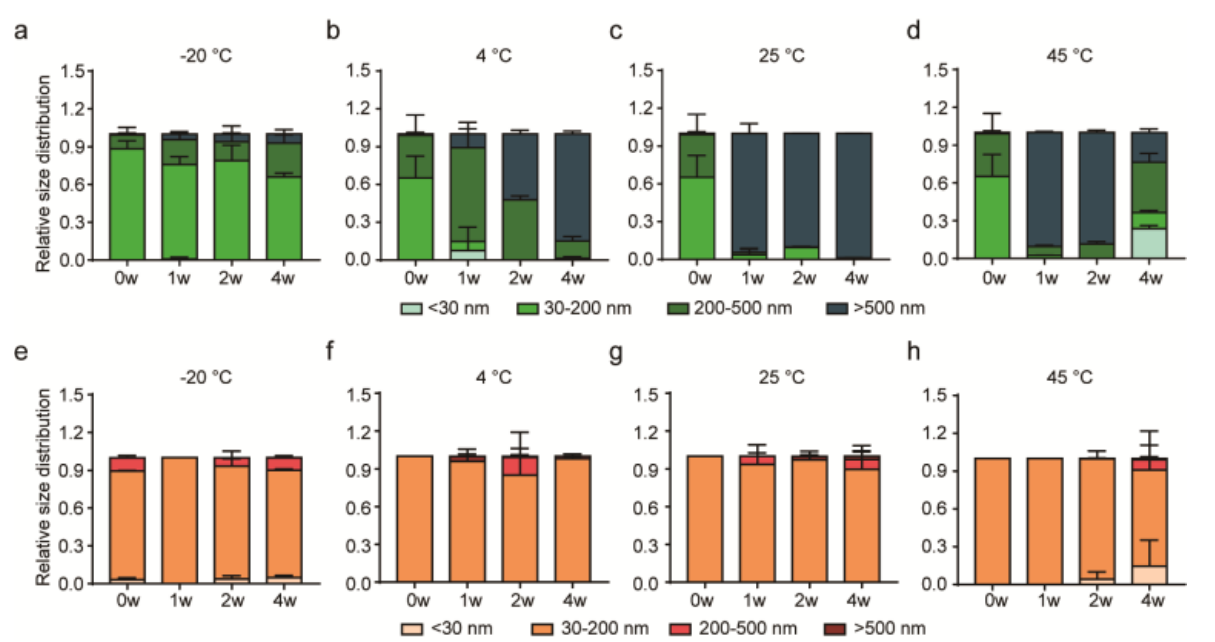
Figure 2. Size distribution changes over time in the various formulations stored at different temper- atures. ( a – d ) Size distributions over time for LEVs stored at − 20, 4, 25, and 45 °C. ( e – h ) Size distributions over time for LEVs-TMO stored at − 20, 4, 25, and 45 °C. Data are presented as mean ± standard error of mean (SEM).